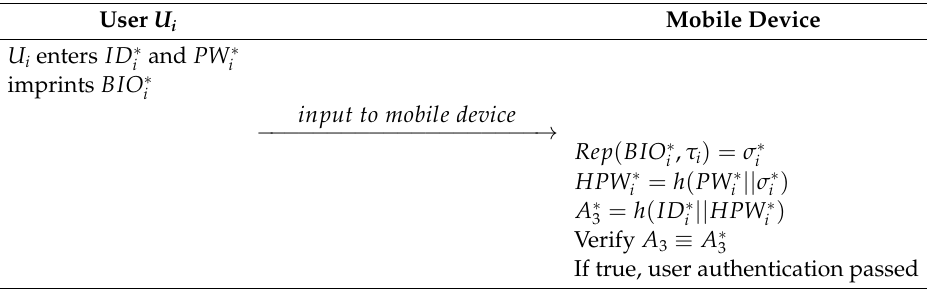
Figure 6. Login phase of the proposed